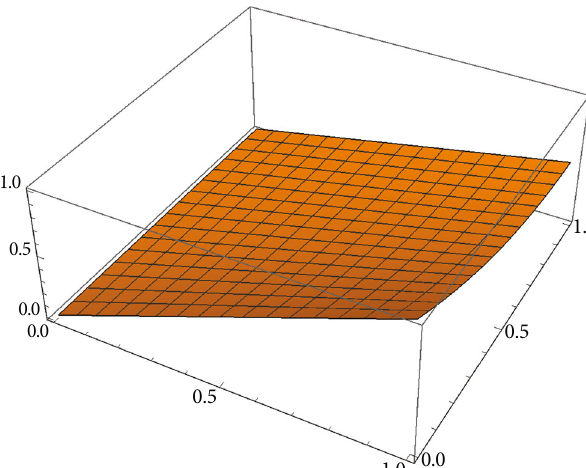
Figure 9: Absolute error for Example 7. Table 7: Comparison of the MAEs of Example 8 for M = 4 .